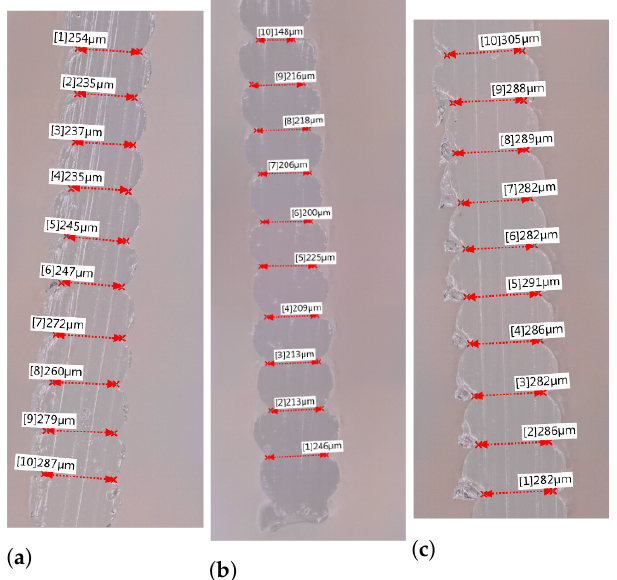
Figure A9. Examples of microscopy images utilized for weld length determination. ( a ) Around layer 10 of Condition 1: HMWPA, T liquefier = 260 °C, v print = 11 mm/s and T build plate = 110 °C. ( b ) Around layer 40 of Condition 3: HMWPA, T liquefier = 240 °C, v print = 11 mm/s and T build plate = 110 °C. ( c ) Around layer 40 of Condition 8: HMWPA, T liquefier = 260 °C, v print = 5.5 mm/s and T build plate = 40 °C.